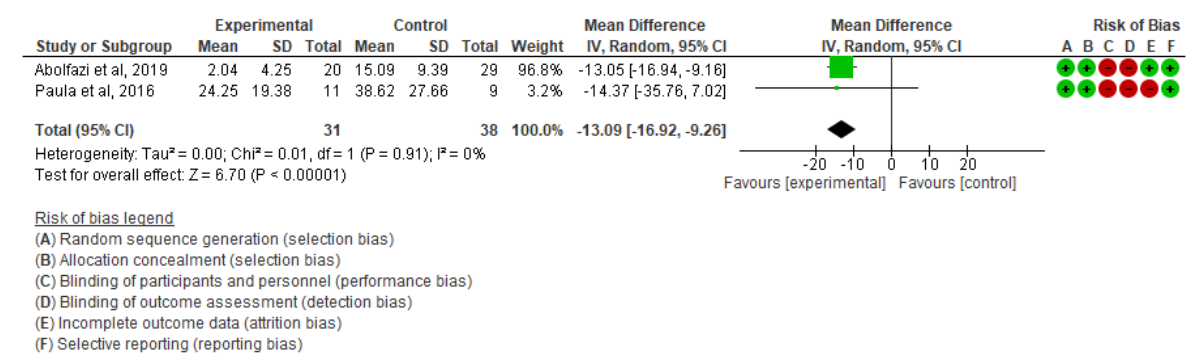
Figure 3. Effect of Mirror Therapy as Measured with DASH: 10–12 weeks post-intervention [39,35].